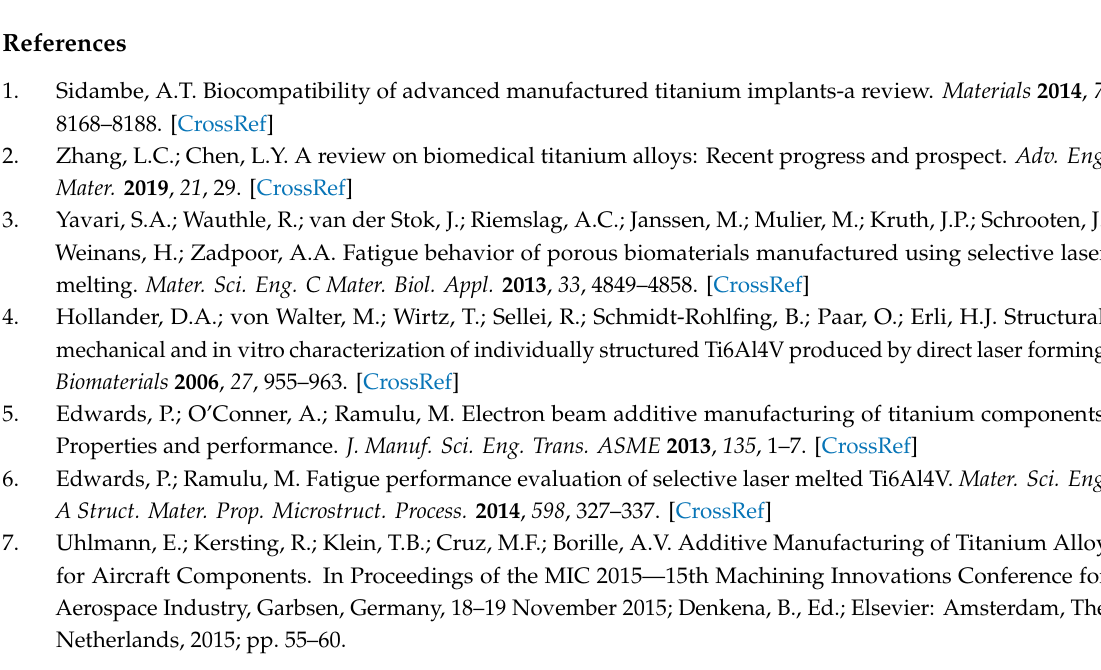
Figure A3. Aspects of the surface of the as-built specimen, before the fatigue test.